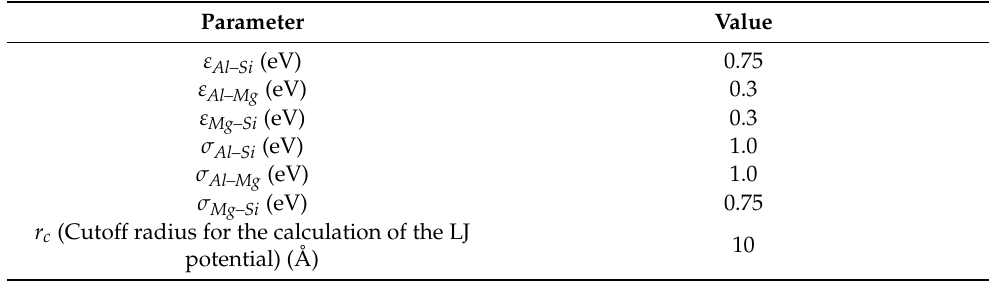
Table 1. Values of the parameters required to calculate the LJ interatomic potential in the given MD simulation